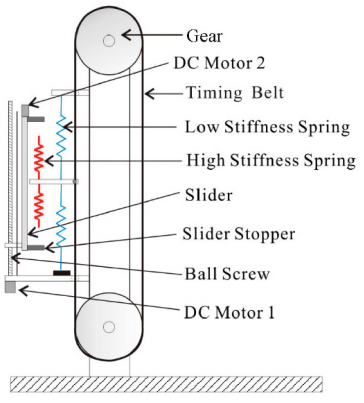
Figure 6. Design outline of the BIASAT mechanism attached to the ankle pitch